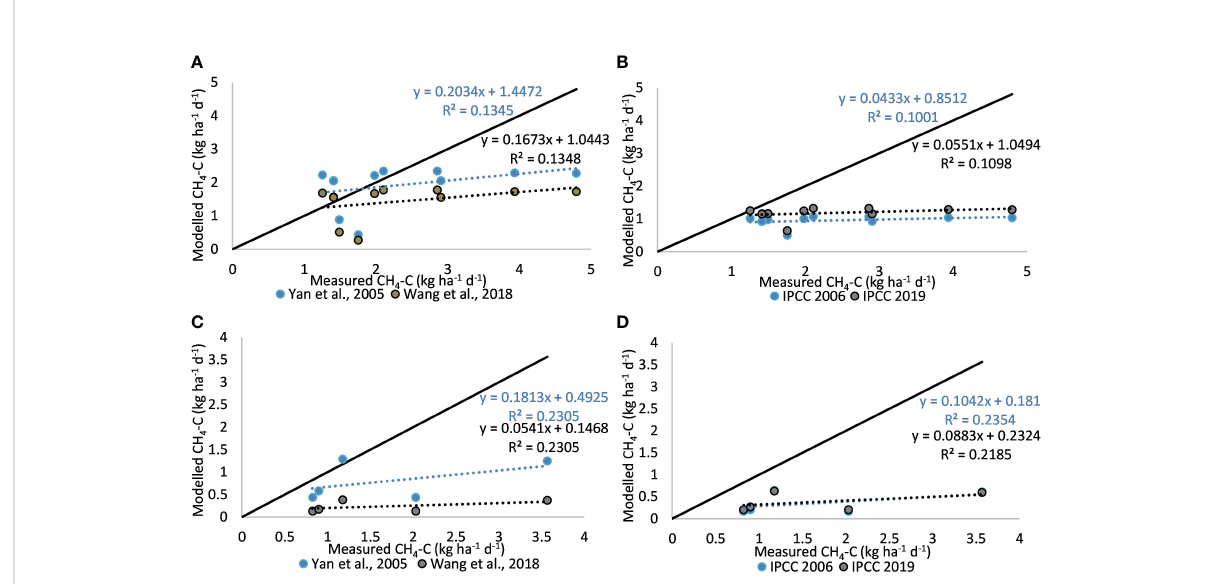
FIGURE 7 Modelled and observed CH 4 emission for the tropical regions outside of Asia. Brazil (A, B) and Ghana (C, D) with Yan and Wang tier 3 models in (A – C) and IPCC tier 1 models in (B – D) (solid line indicates 1:1). Sample number = 5 for Ghana and 11 for Brazil.